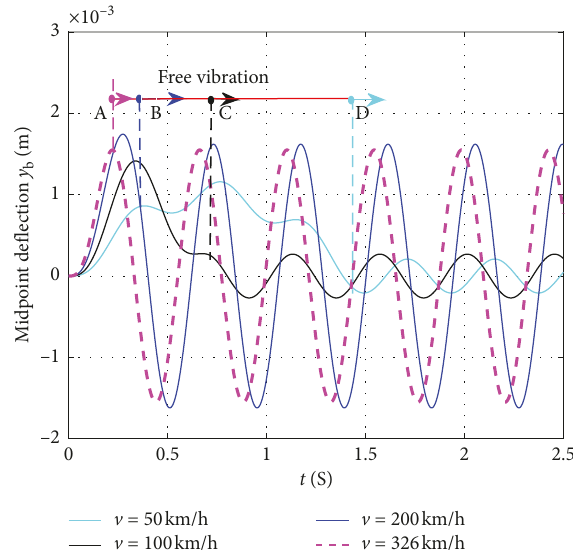
Figure 8: Vertical displacement of bridge span at different